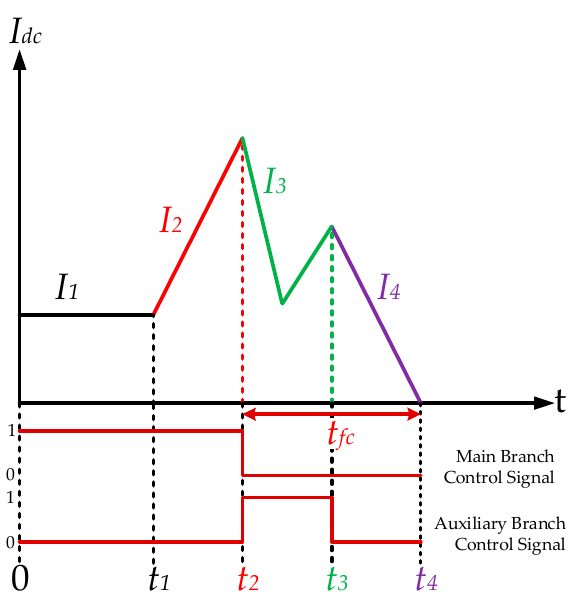
Figure 7. The graphical illustration of estimated DC current with control signals.